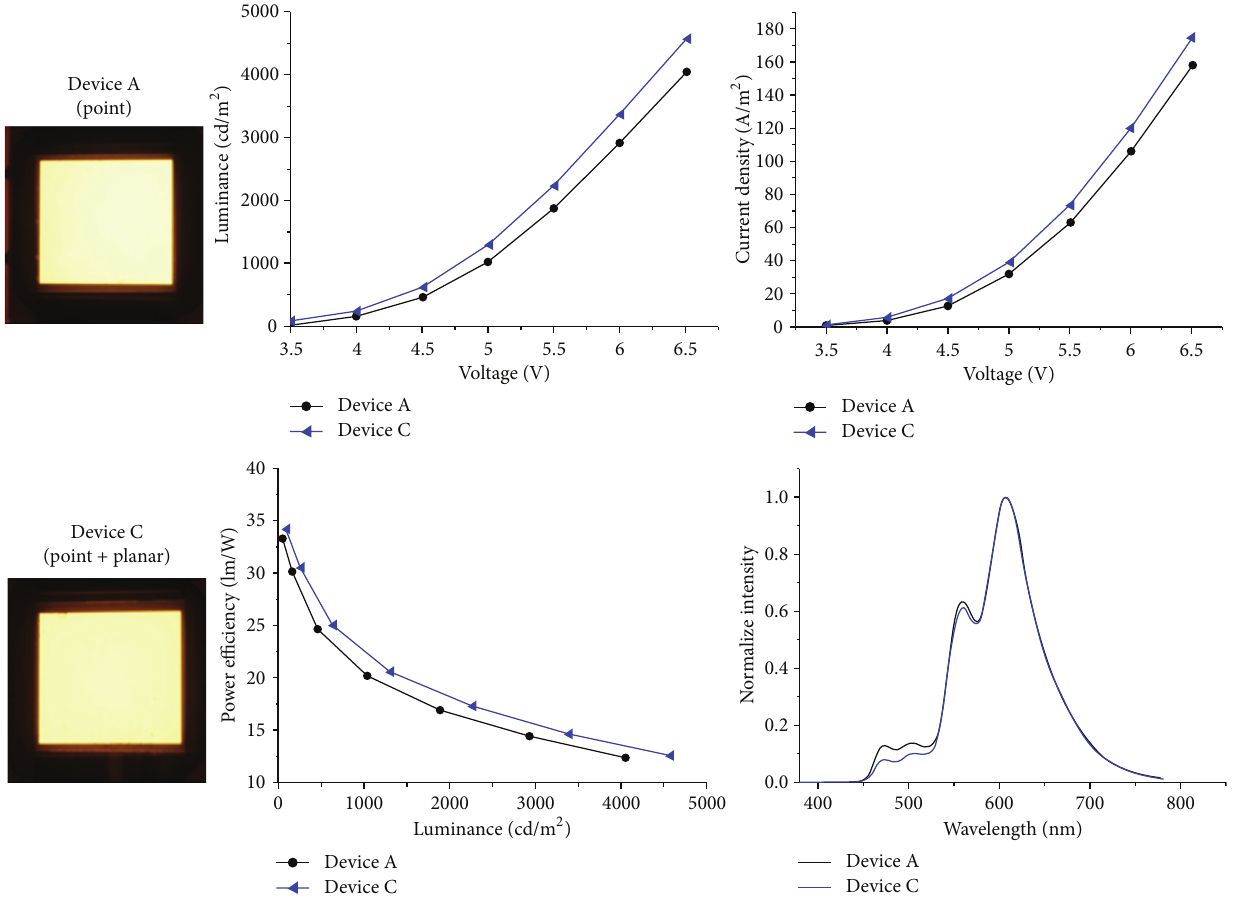
Figure 11: The device performance compared with that of a device prepared using a complete conventional point